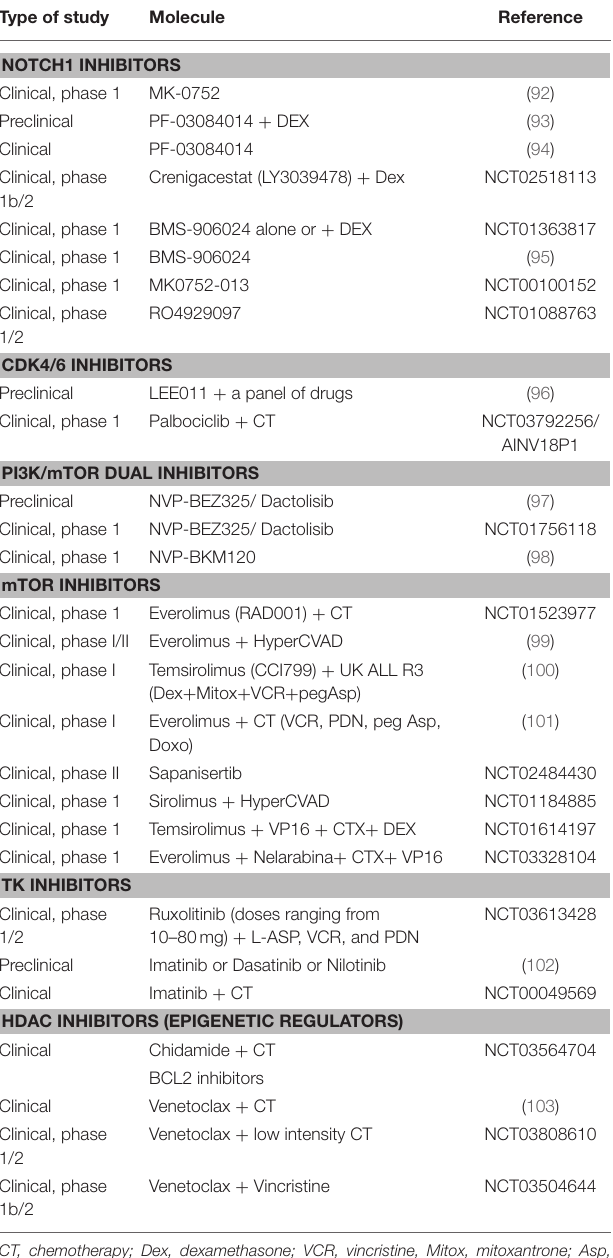
TABLE 2 | Clinical and preclinical trials with target therapies in T-cell acute lymphoblastic